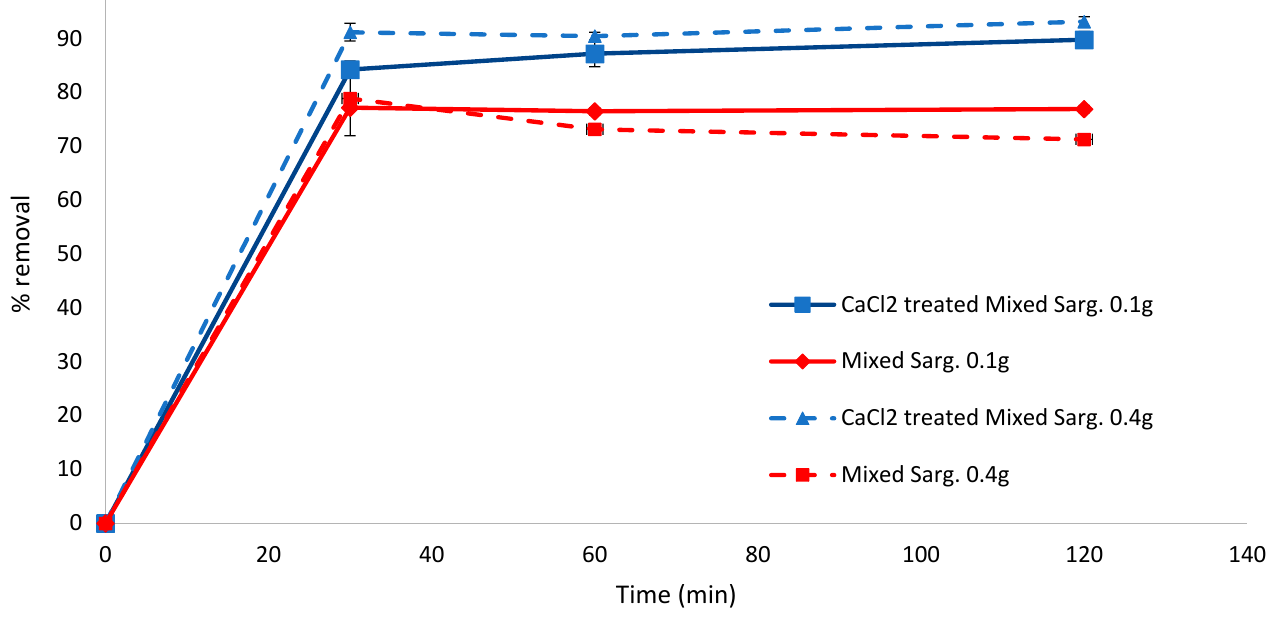
Figure 3. Biosorption of methylene blue over 120 min using CaCl 2 -pretreated or untreated mixed Sargassum biomass (0.1 and 0.4 g). Standard deviation n = 3.